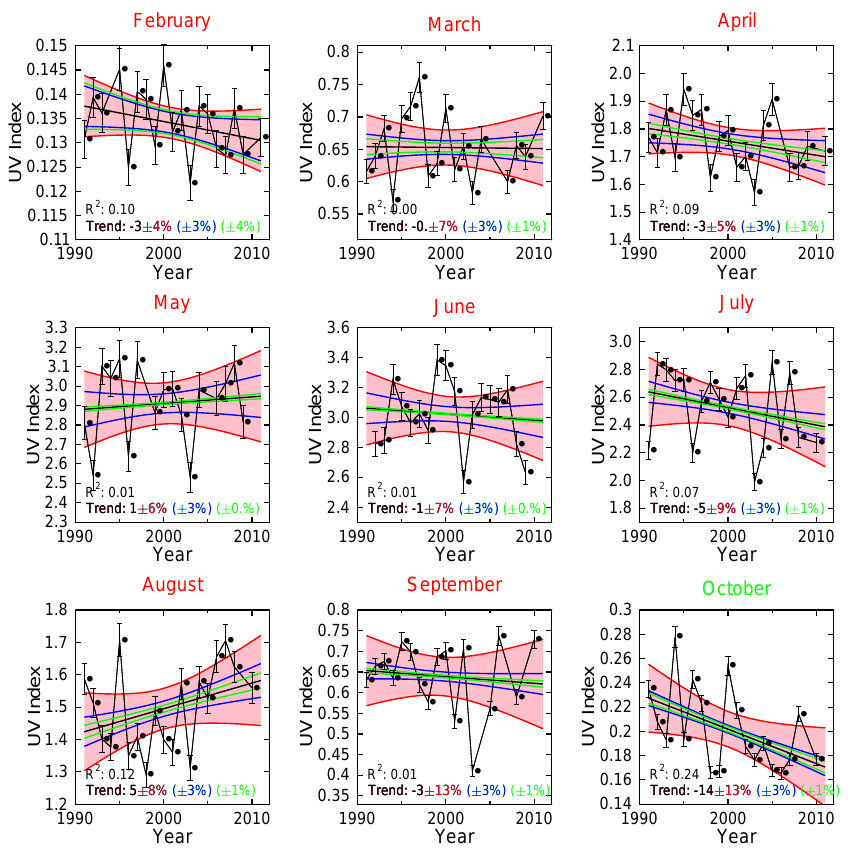
Fig. 4. Same as Fig. 2, but for the UV Index.